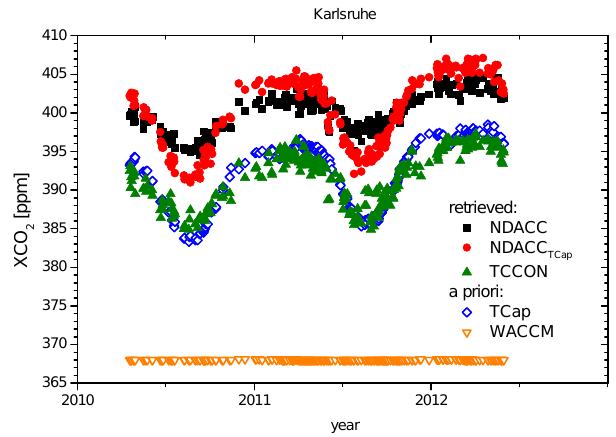
Figure 1. XCO 2 data sets for Karlsruhe, Germany (mid-latitude, Northern Hemisphere). Black: retrieved from NDACC spectra using Fig. 1. XCO 2 data sets for Karlsruhe, Germany (mid-latitude, fixed WACCM a priori, red: retrieved from NDACC spectra using northern hemisphere). Black: retrieved from NDACC spectra using TCCON a priori, green: TCCON, blue: TCCON a priori, orange: fixed WACCM a priori, red: retrieved from NDACC spectra using WACCM a TCCON a priori, green: TCCON, blue: TCCON a priori, orange: WACCM a priori.